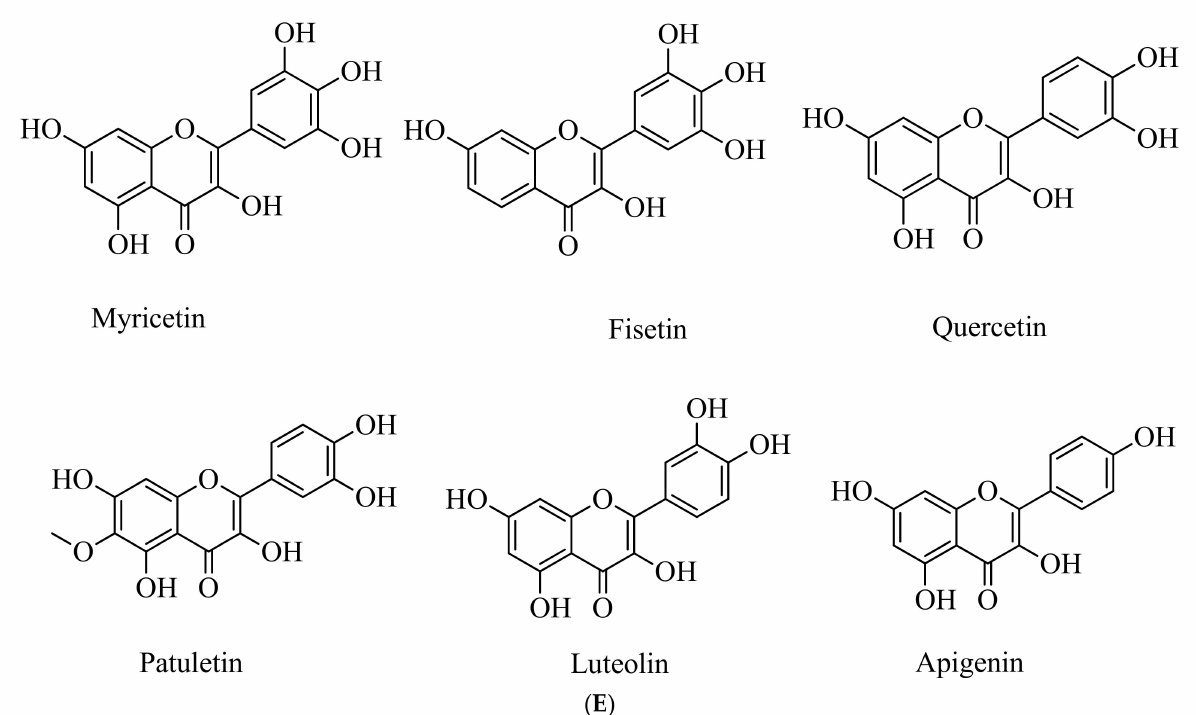
Figure 2. Chemical structure of ( A ) terpenes and terpenoids, ( B ) phytosterols, ( C ) alkaloids, ( D ) tocols, and ( E )